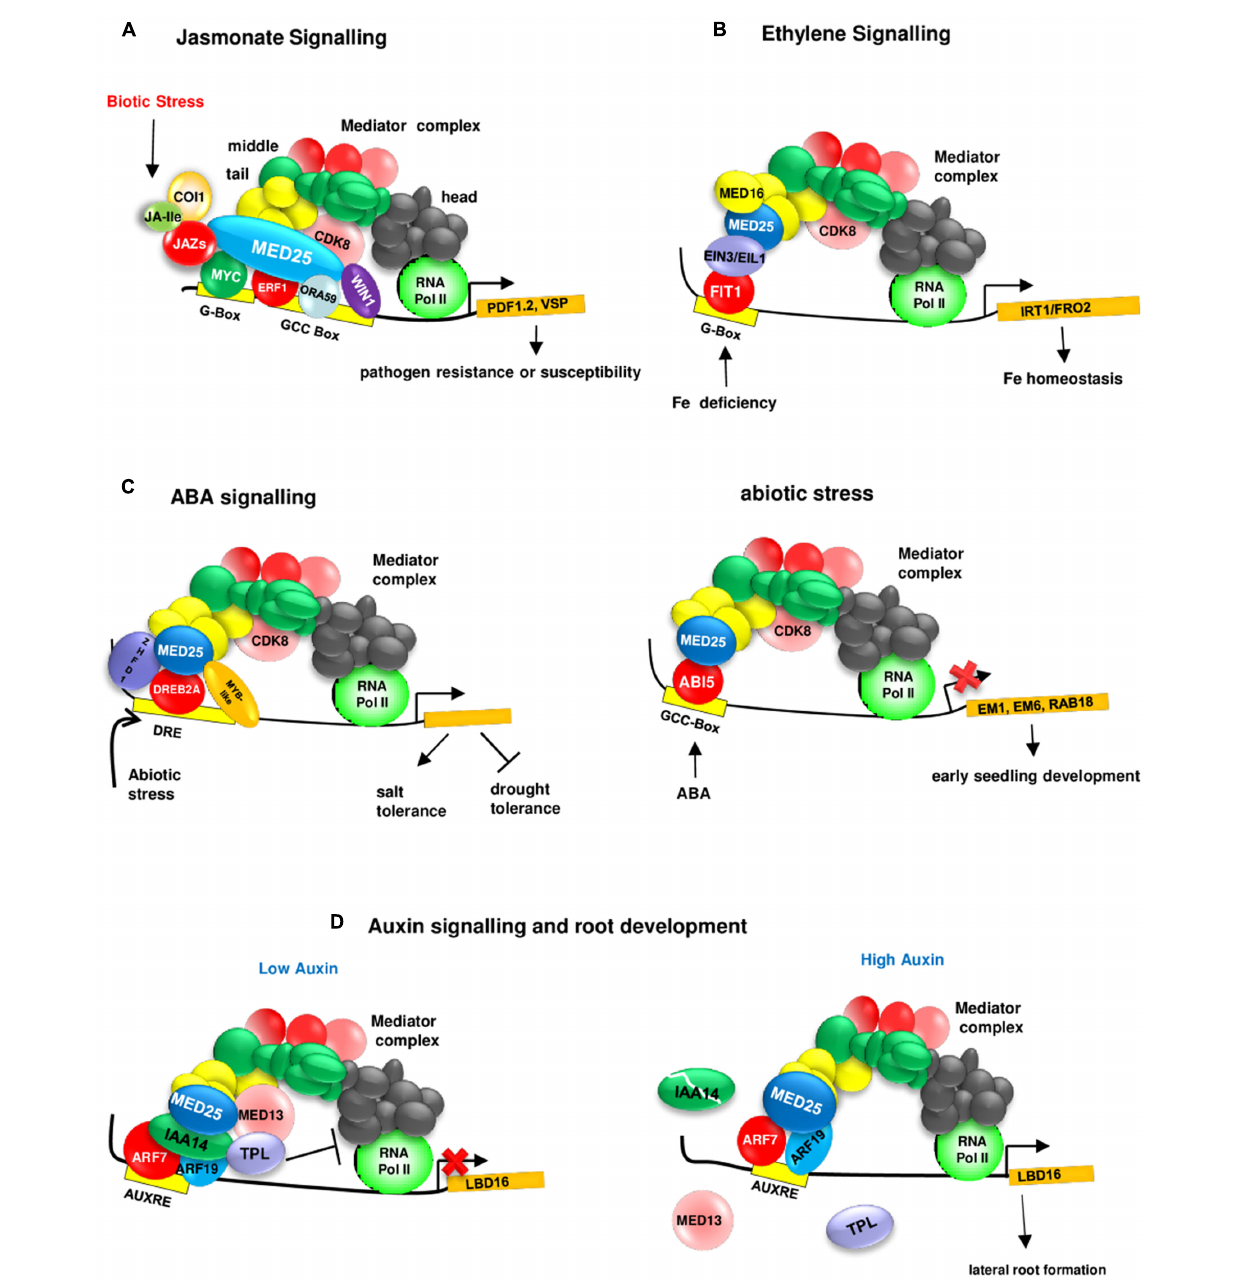
FIGURE 2 | MED25 regulates plant hormone signaling through its interaction with different transcriptional regulators. (A) MED25 is a master regulator of JA signaling. MED25 interacts with JAZ proteins acting as repressors of JA signaling, multiple activators (e.g., MYCs that bind to the G-box and AP2/ERFs that bind to the GCC box) and recruits RNA polymerase II to the promoters of JA-responsive genes such as ( PDF1.2 and VSP1 ). JA-Ile:Jasmonate Isoleucyl. Please see text for additional details. (B) MED25 is a regulator of ethylene signaling during nutrient deficiency responses. MED25 by interacting with the ET signaling components EIN3 and EIL1 and the Mediator complex subunit MED16 plays a role in transmitting iron deficiency signals to RNA Pol II for the activation of genes (e.g., IRT1 / FRO2 ) involved in iron homeostasis. Please see text for additional details. MED16, MEDIATOR 16; EIN3, ETHYLENE INSENSITIVE 3; EIL1, ETHYLENE INSENSITIVE 3 LIKE 1. (C) MED25 is a regulator of ABA (left image) and abiotic stress (right image) signaling. MED25 interacts with the ABI5 TF and negatively regulates the expression of ABA-responsive genes ( EM1 , EM6, and RAB18 ) involved in early seedling development. MED25 interacts with abiotic stress responsive TFs (such as DREB2A, which binds to the DRE box) and positively and negatively regulates salt and drought tolerance. (D) MED25 is a regulator of auxin signaling. Under low auxin levels (left image), a suppressive complex involving AUX/IAA14, TPL, and MED13 form a suppressive complex at the promoter (right image) of LBD19 encoding a TF involved in lateral root development to inhibit the interaction between the core Mediator complex and RNA Pol II. Auxin leads to the destruction of this complex and ARF7 and ARF19, positive regulators of auxin signaling interact with MED25 and recruit RNA Pol II to the LBD16 promoter.